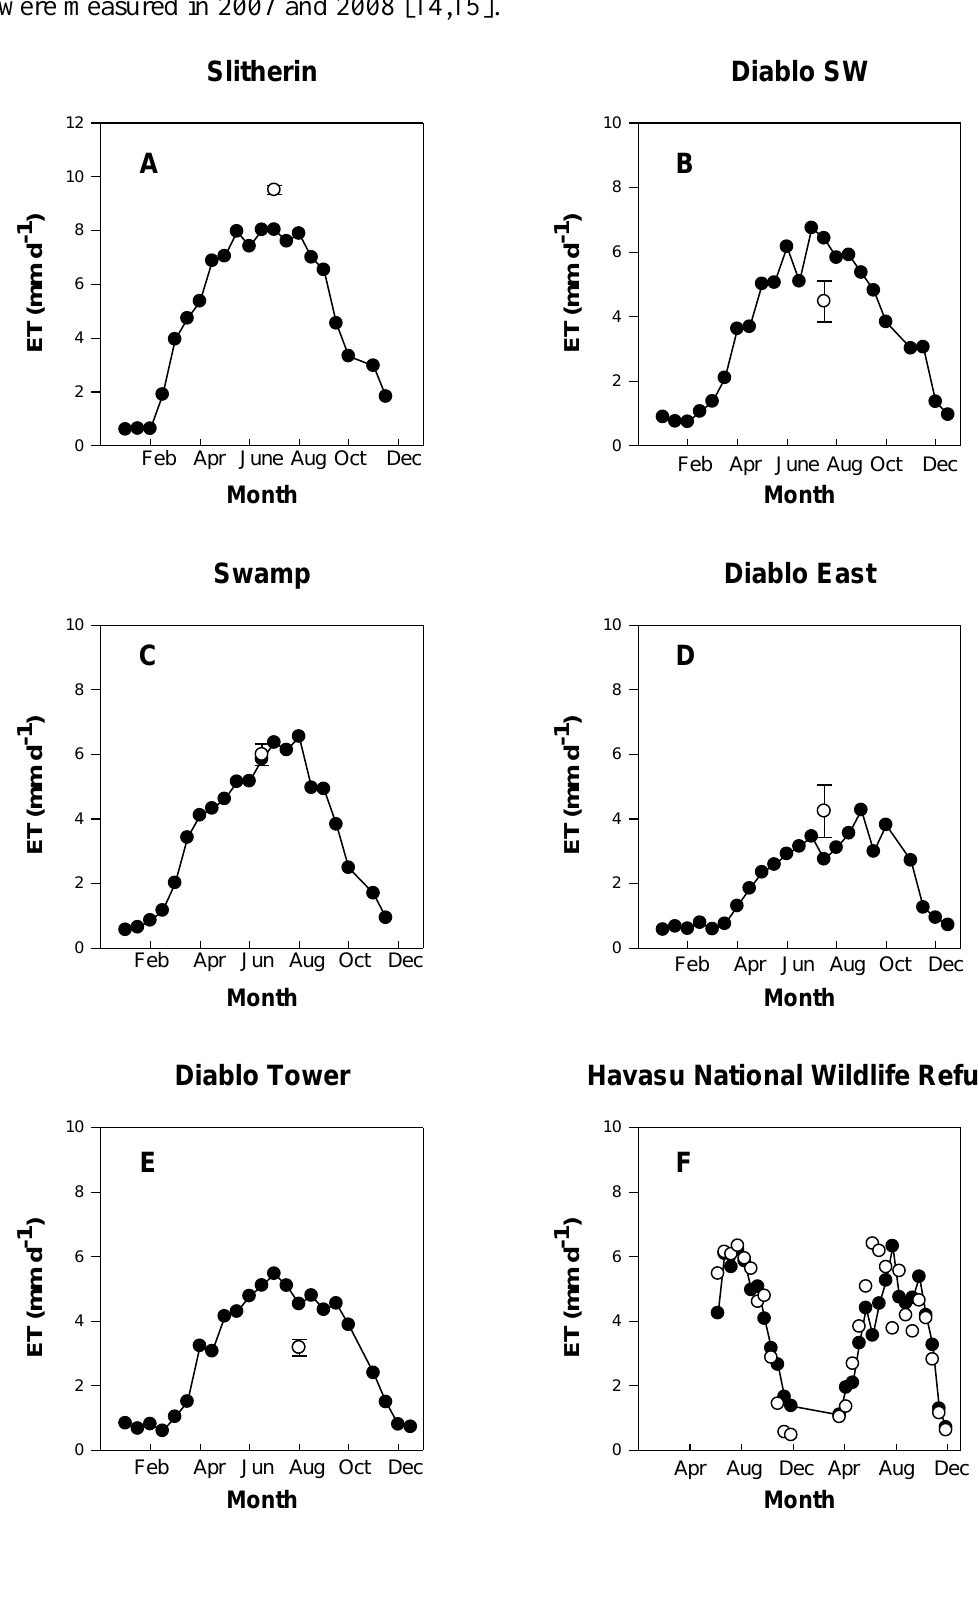
Figure 3. MODIS estimates (closed circles) of saltcedar ET at six sites at Cibola National Wildlife Refuge on the Lower Colorado River plotted against ground estimates from sap flow sensors (open circles). Havasu data were collected in 2003–2003 [18]; other sites were measured in 2007 and 2008